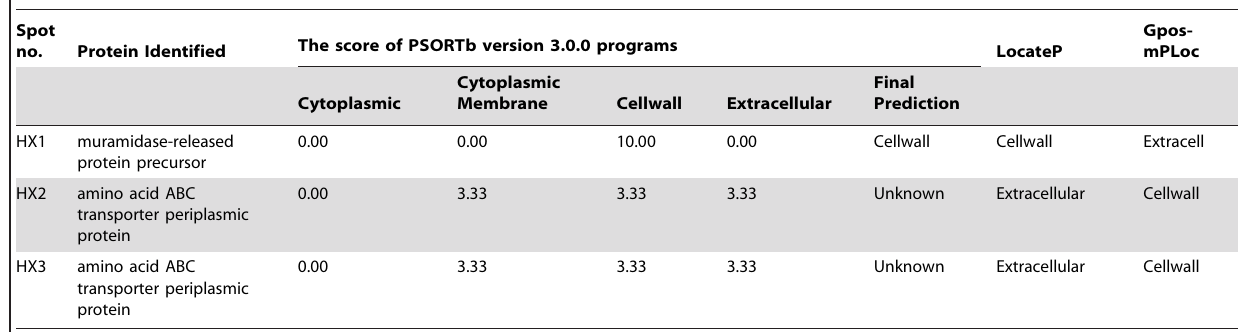
Table 1. The predicated subcellular location of differential proteins.